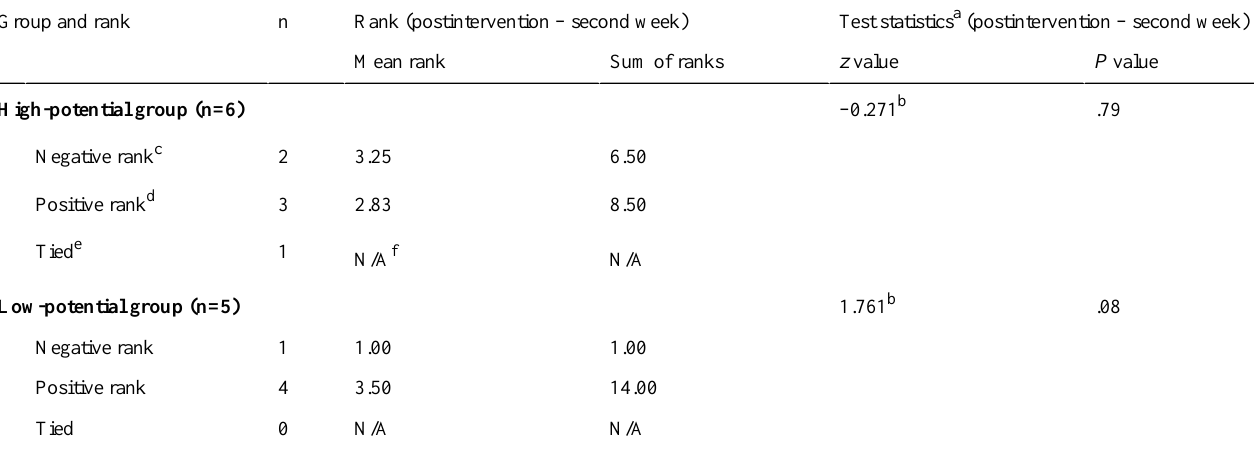
Table 3. Ranks and test statistics for the System Usability Scale (SUS) scores from the second-week and postintervention surveys for the high-potential and low-potential groups (N=11).